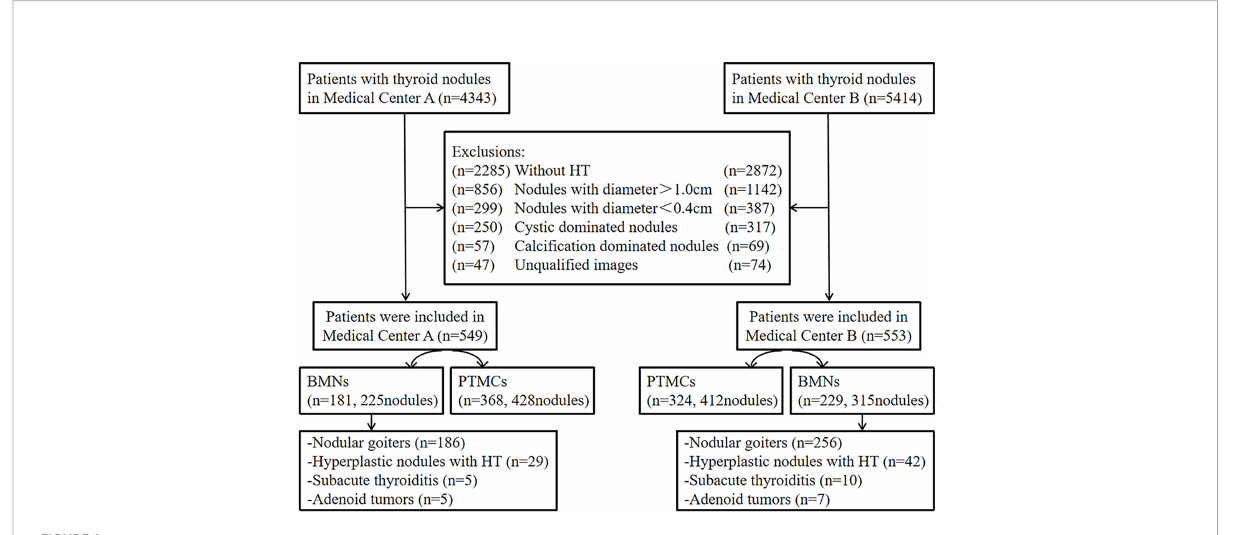
FIGURE 1 Flow chart of the study